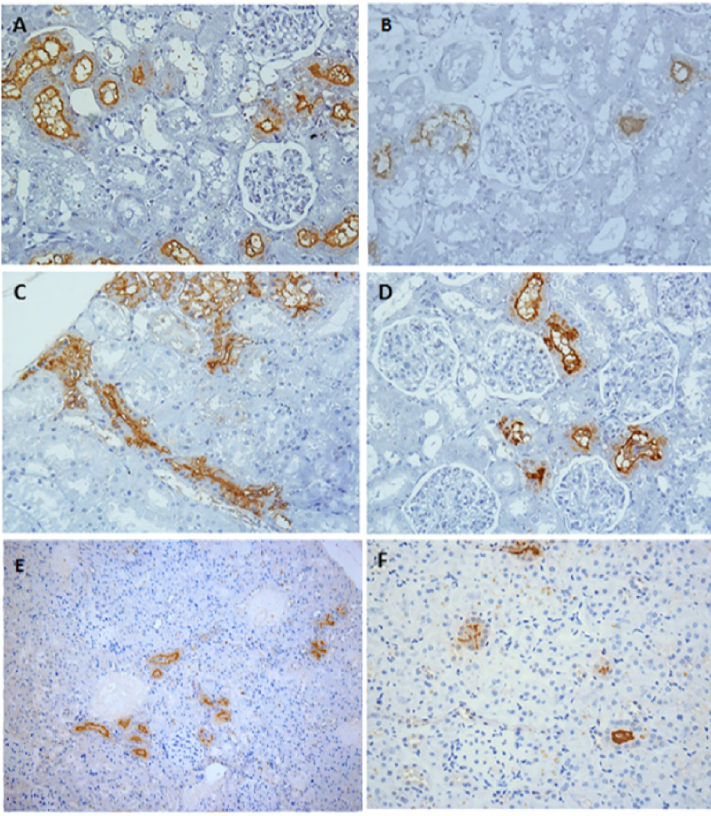
to complete pattern of CT lumen occlusion; (D) marking restricted to the membrane of renal epithelium (partial occlusion); (E) agglomerated CTs distributed in the renal cortex; (F) isolated CTs distributed in the cortex. A, B, C